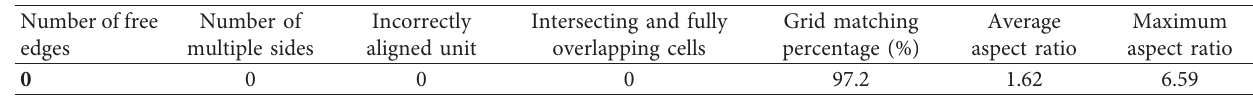
Table 2: Result of mesh repair.